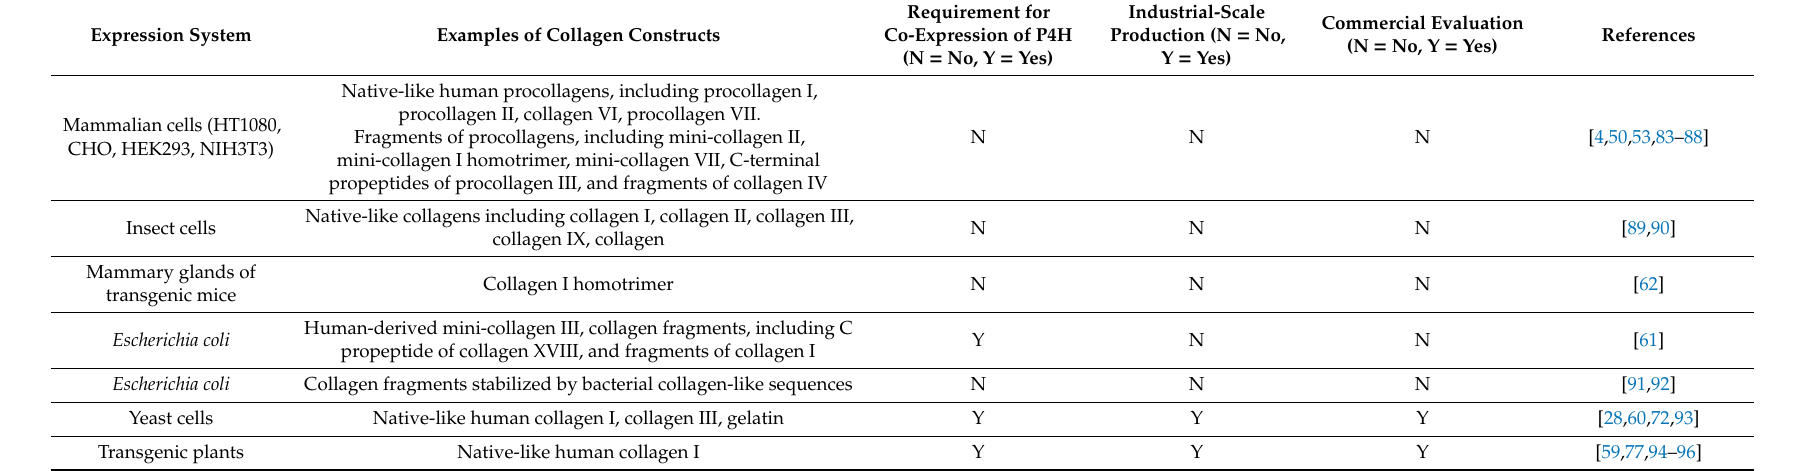
Table 1. A summary of the expression systems for production of recombinant